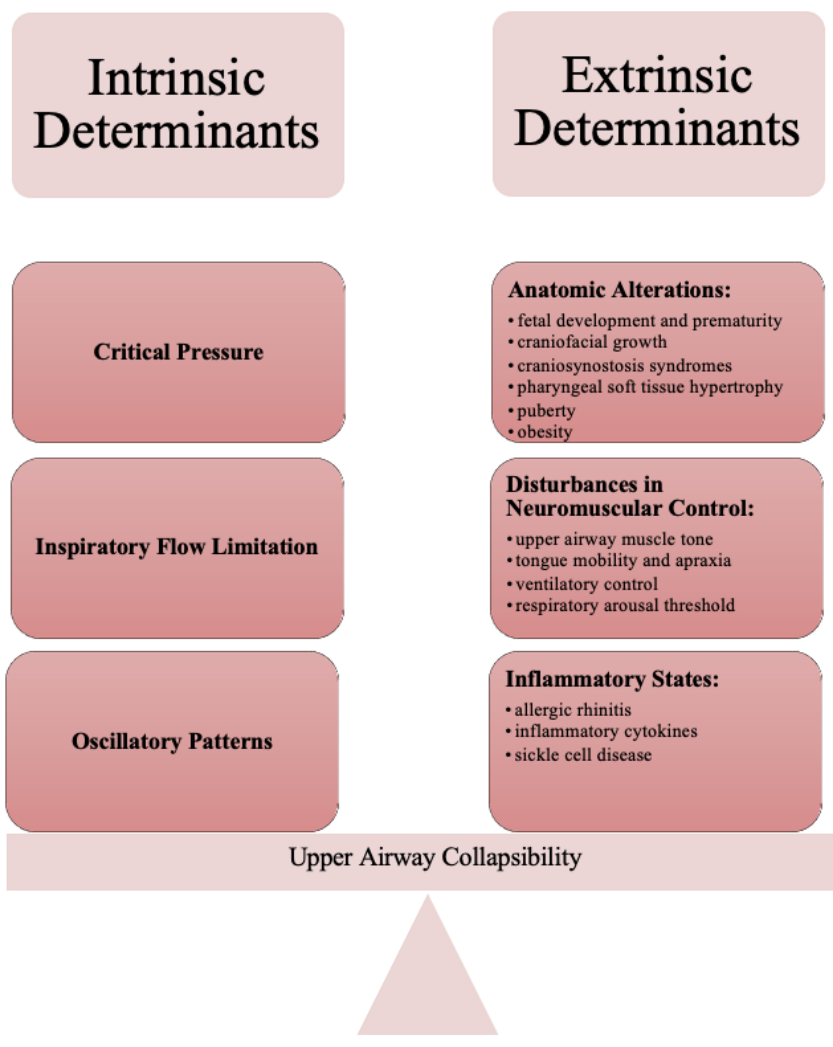
Figure 1. Intrinsic and Extrinsic Determinants of Upper Airway Collapsibility that affect the fine balance of airway patency during sleep